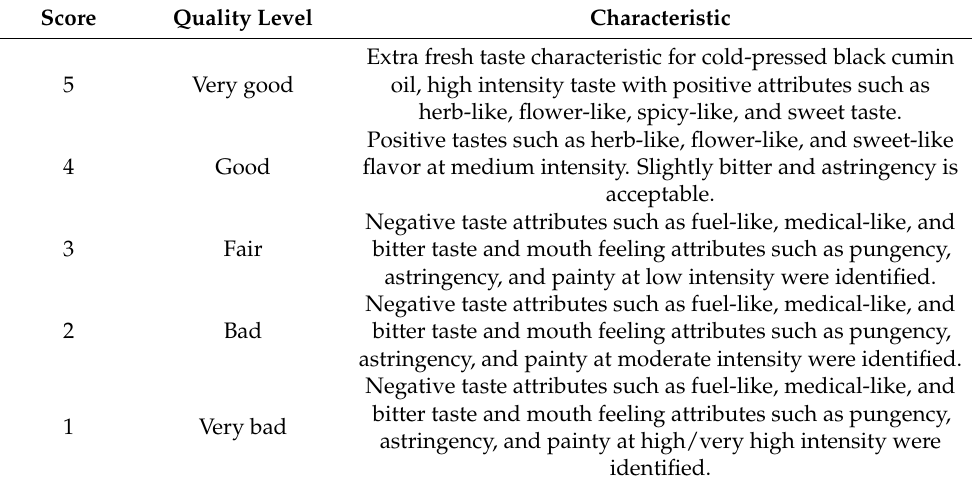
Table 2. Overall sensory quality. General characteristics of cold-pressed black cumin